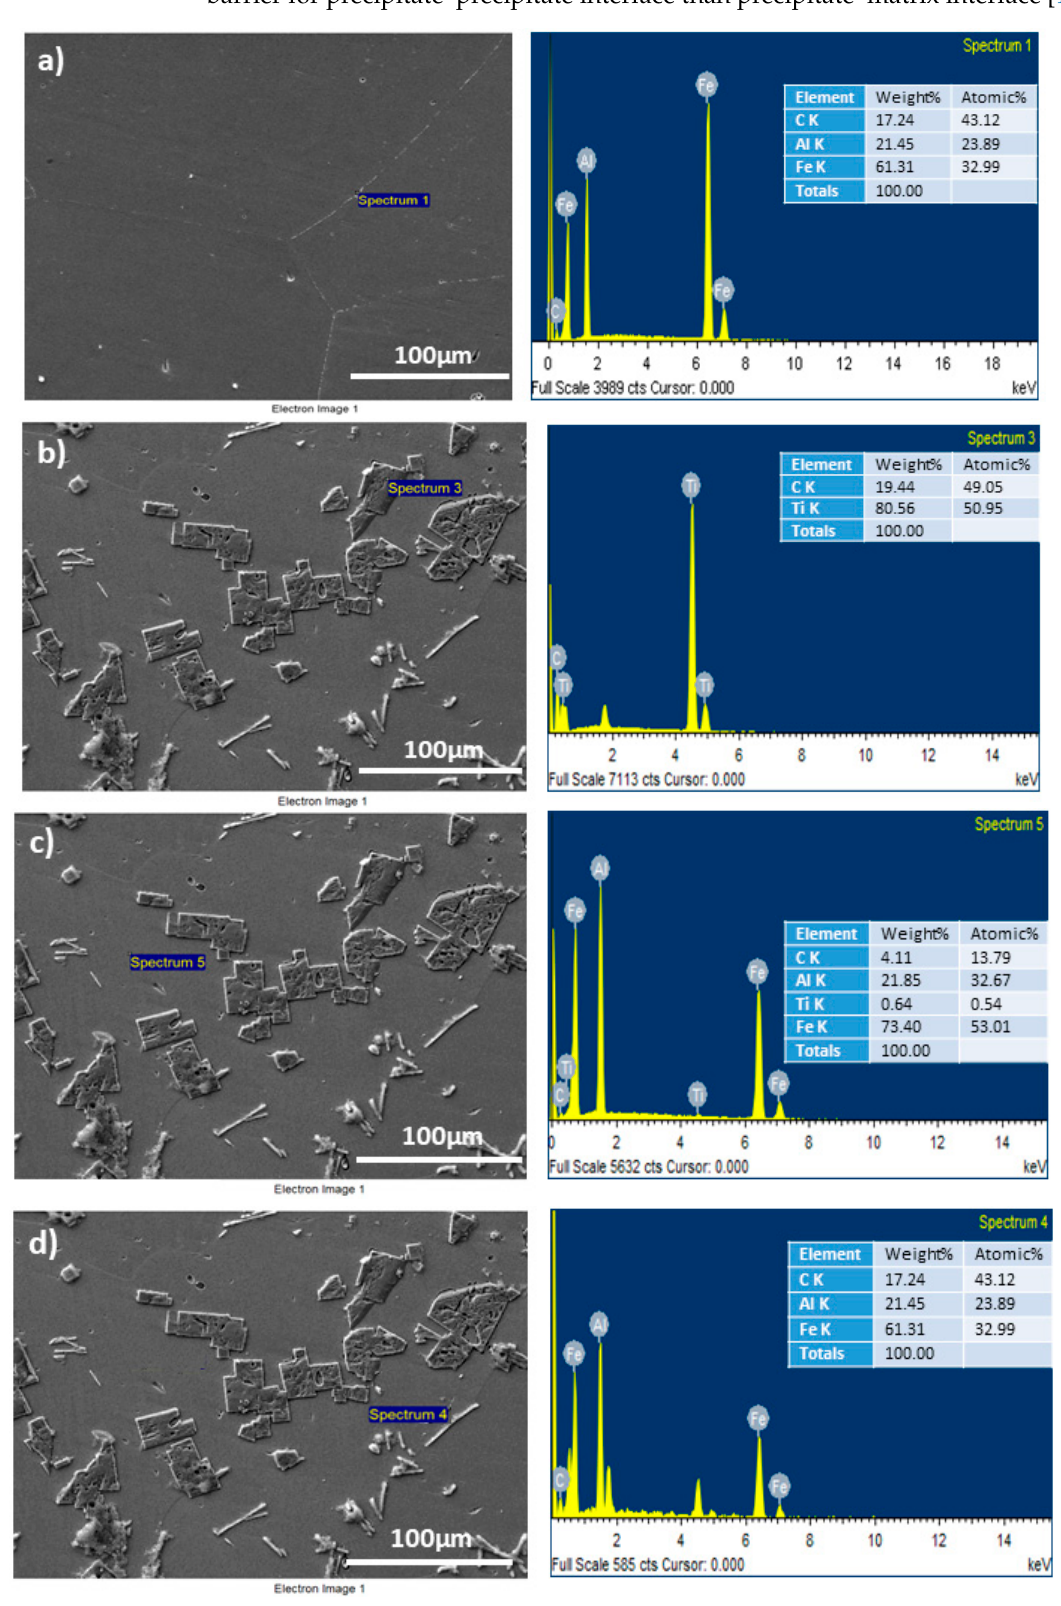
Figure 2. EDS analysis of ( a ) needle like Fe 3 AlC 0.5 carbide in C01T0, ( b ) TiC, ( c ) matrix, and ( d ) needle like Fe 3 AlC 0.5 carbide in C1T5.